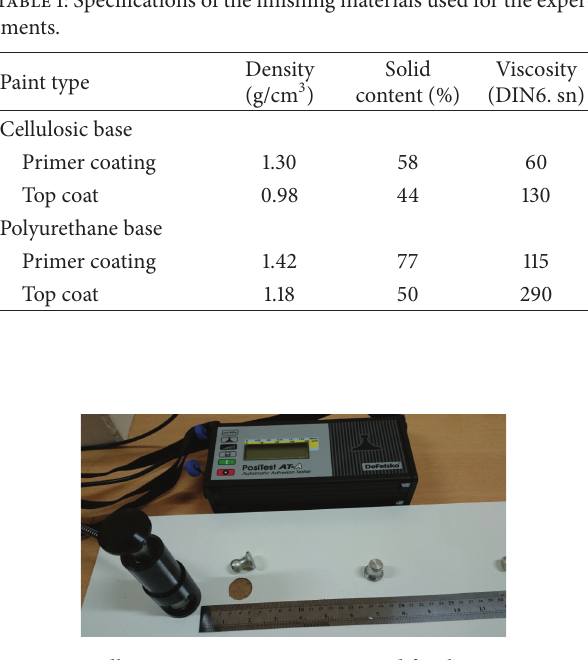
Figure 1: Adhesion resistance test setup used for the experiments.